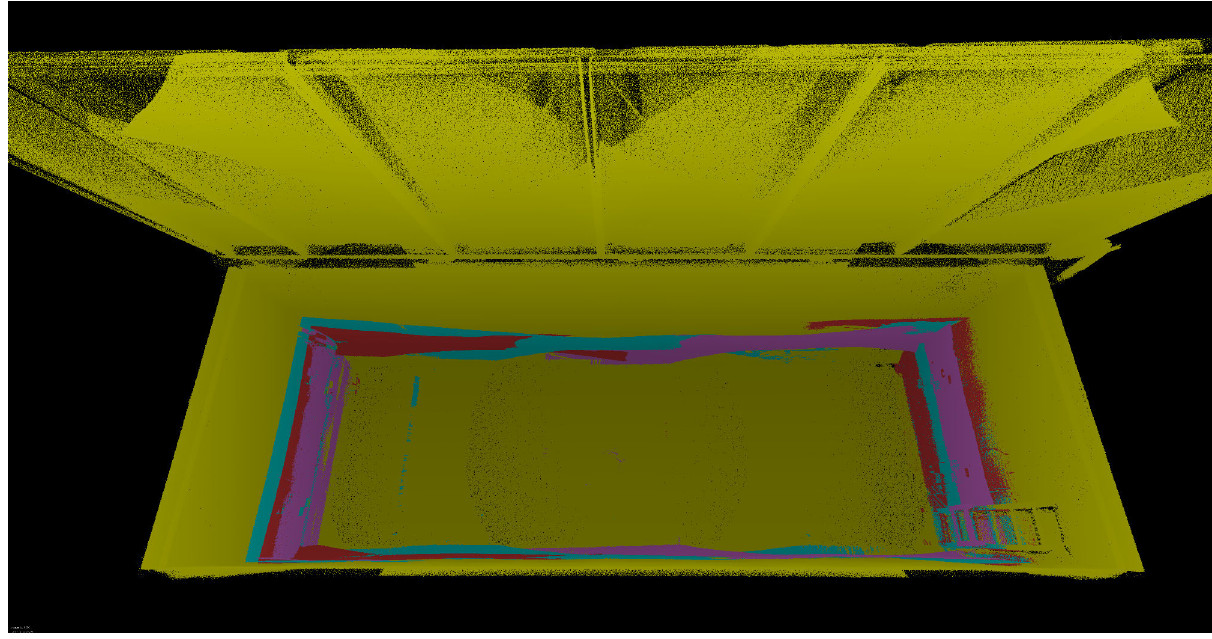
Figure 10. The point clouds of the container. The yellow one is acquired with the Riegl VZ-400 and serves as ground through, the others are acquired with the underwater scanner. It can be seen that the errors are very small.